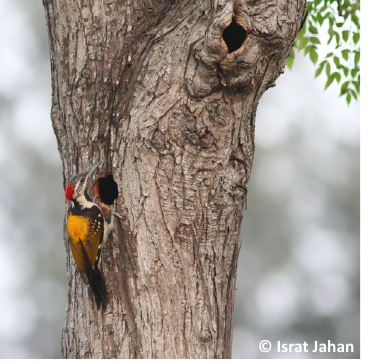
Image 10. Nest of Black-rumped